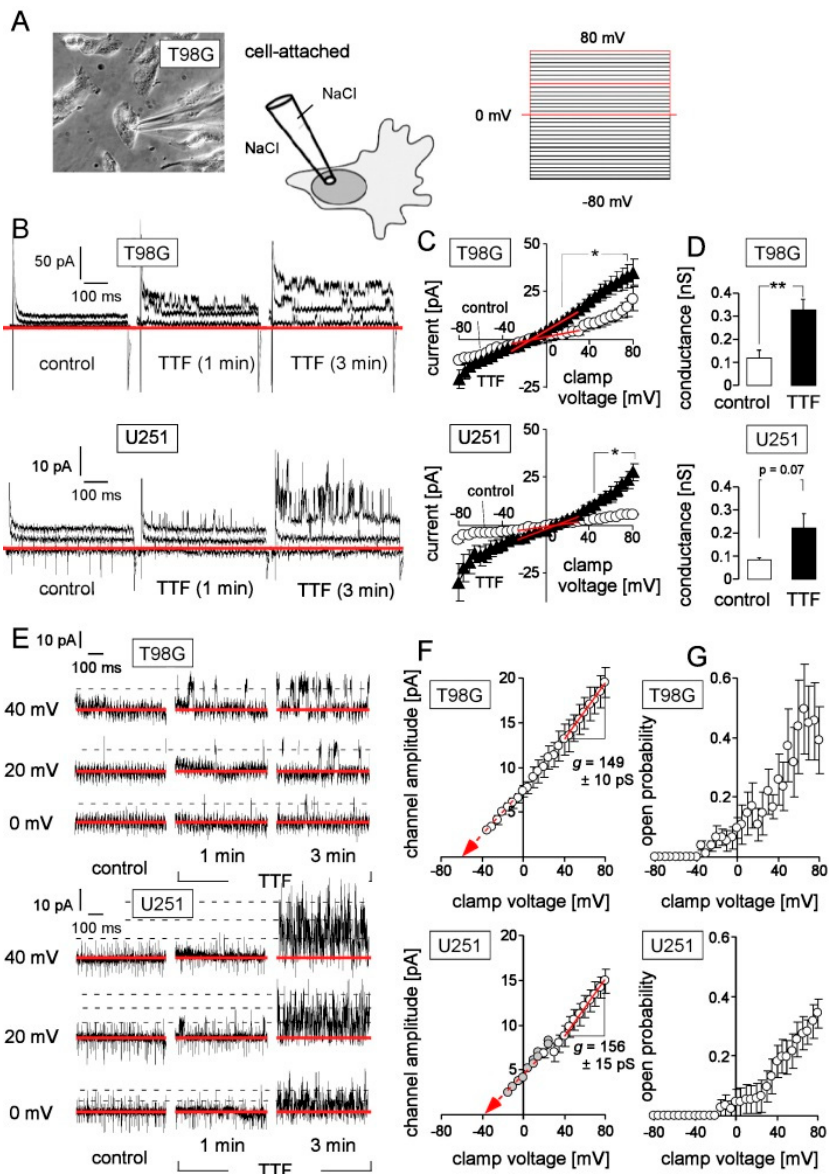
Figure 3. TTFields activate BK K + channels. ( A ) Macroscopic cell-attached currents were recorded from T98G (micrograph on the left) and U251 cells with the patch-clamp technique using a physiological NaCl-rich extracellular solution in bath and pipette (middle). Currents were elicited by 33 square pulses (700 ms each) to voltages between − 80 and +80 mV delivered from 0 mV holding potential in 5 mV increments as shown by the voltage-clamp pulse protocol on the right. ( B ) Cell- attached current tracings recorded as in ( A ) from a T98G (top) and a U251 cell (bottom) before (left), after 1 min (middle) and 3 min (right) TTFields (200 kHz, 2.5 V/cm) application. As illustrated by the red lines in the pulse protocol ( A , right), only currents elicited by voltage steps to 0, +40 and +80 mV are shown (red lines in ( B ) indicate the zero current). ( C ) Relationship between the mean (± SE; n = 10–11) macroscopic cell-attached currents and the clamp voltage in control (0 V/cm, open circles) and TTFields (2.5 V/cm)-treated (closed triangles) T98G ( n = 10, top) and U251 cells ( n = 6, bottom). ( D ) Mean (± SE;) conductance of the clamped membrane area in T98G (top) and U251 cells (bottom) as calculated between − 30 and +30 mV clamp voltage from the data in ( C , red lines) by linear regression. * and ** in ( C , and F , top) indicate p ≤ 0.05 and p ≤ 0.01, respectively, Welch-corrected t -test. The square brackets in ( C ) mark the voltage range, where control and TTFields-stimulated cell-attached currents differ significantly; the number in ( D , bottom) indicates the p value. ( E ) Cell-attached current tracings recorded in a T98G (top) and a U251 cell (bottom) at 0, +20 and +40 mV clamp voltage before (control)